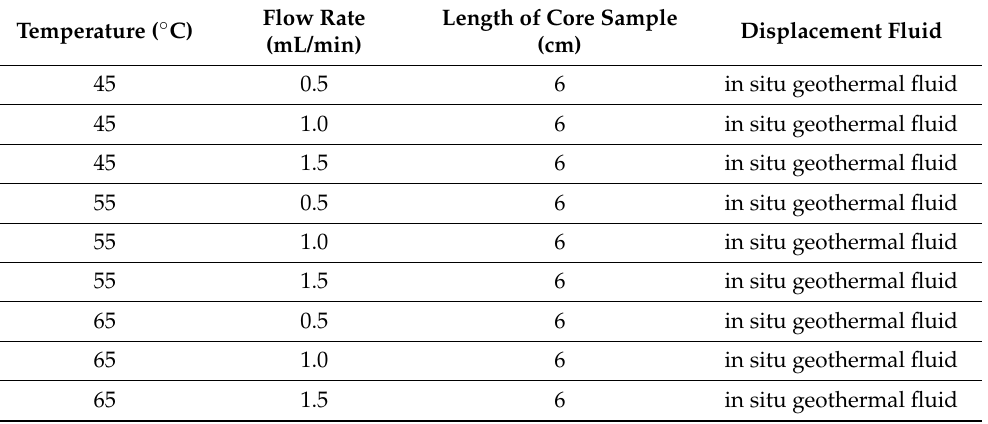
Table 1. Experimental design of variables for core sample displacement experiments.